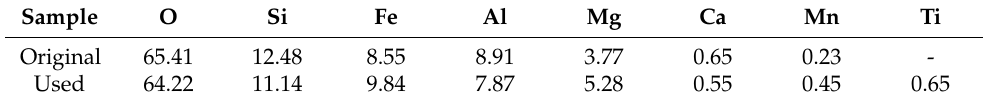
Table 4. Element analysis results—average percentage of the atomic weight from 10 measurements.